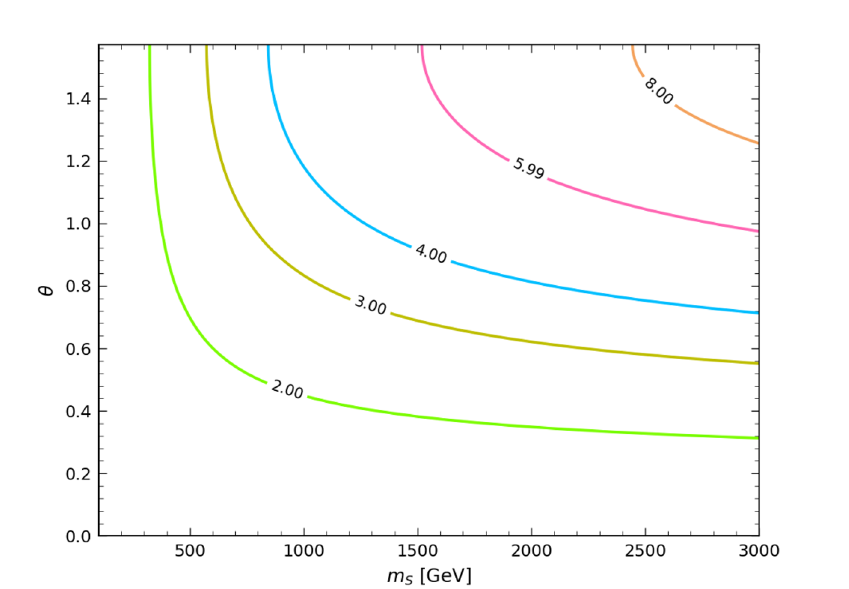
Figure 6 . Contours of (cid:1) (cid:31) 2